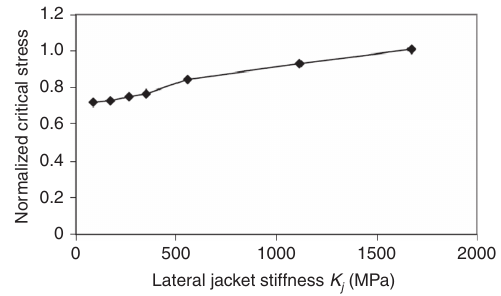
Figure 16 Normalized critical stress versus lateral jacket stiffness.